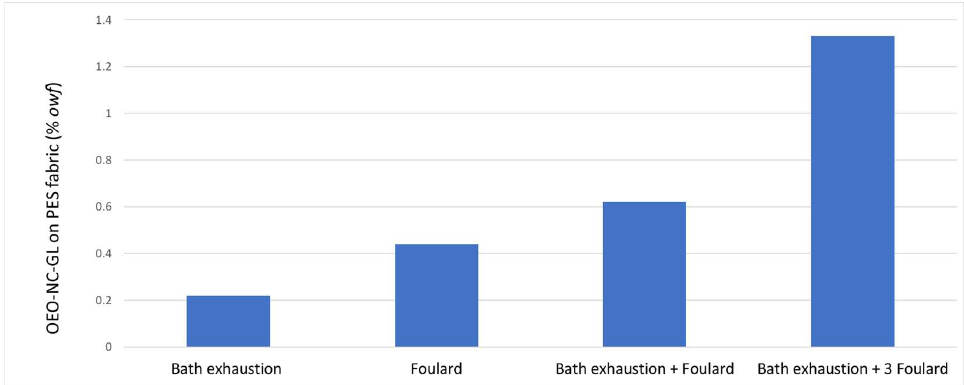
Figure 2. OEO-NC-GL adsorption onto PES textiles: comparison of three optimized impregnation methods. ( owf : over weight of fiber).